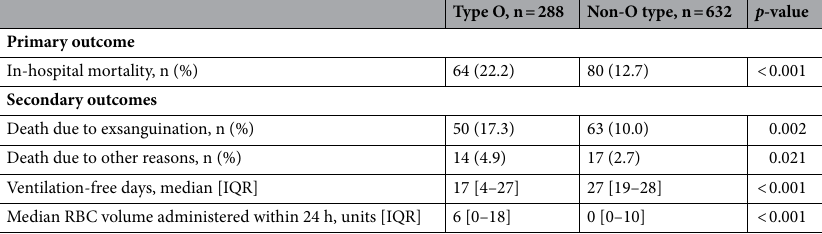
Table 4. Comparison of the outcomes of patients with blood type O versus those of other blood types. IQR interquartile range, RBC red blood cell.